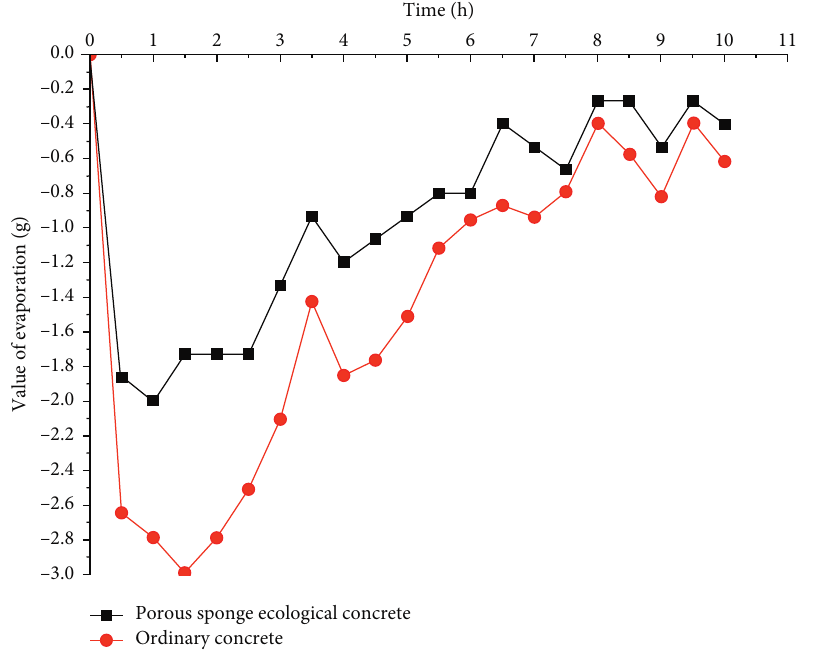
Figure 11: Average water evaporation per unit mass per unit time under different working conditions (50 °